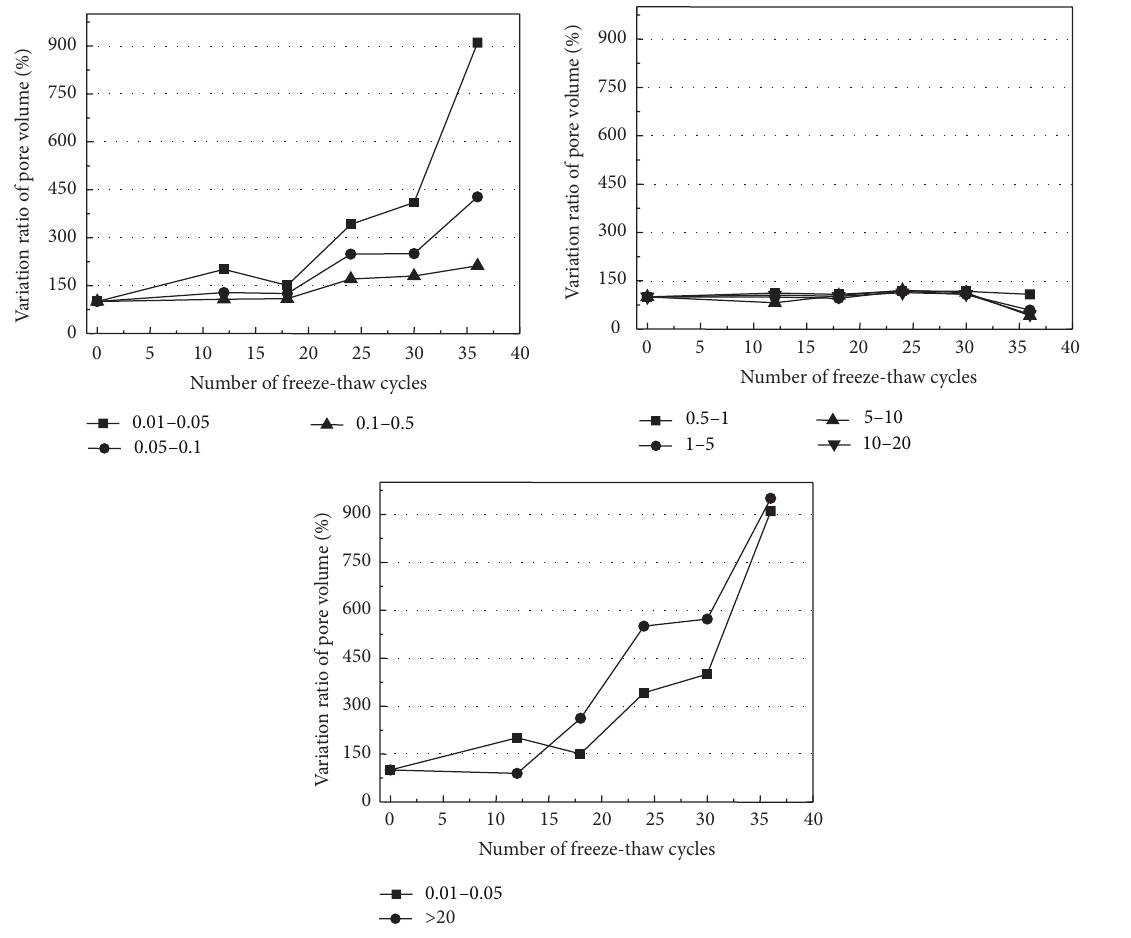
Figure 9: Variation ratio of pore volume of Φ 60 mm circle region of